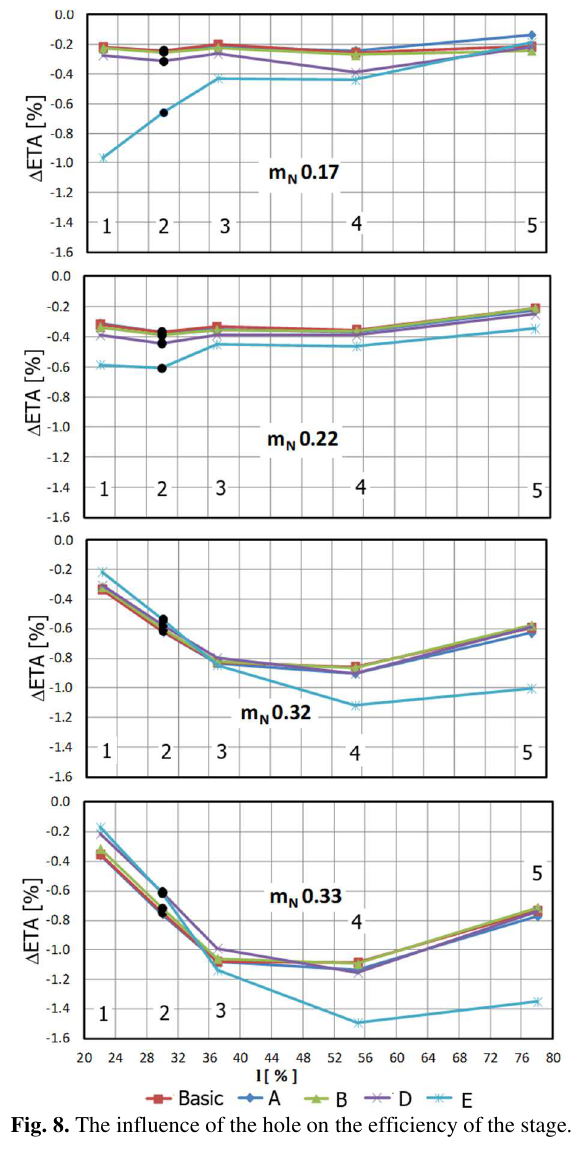
Fig. 8. The influence of the hole on the efficiency of the stage .